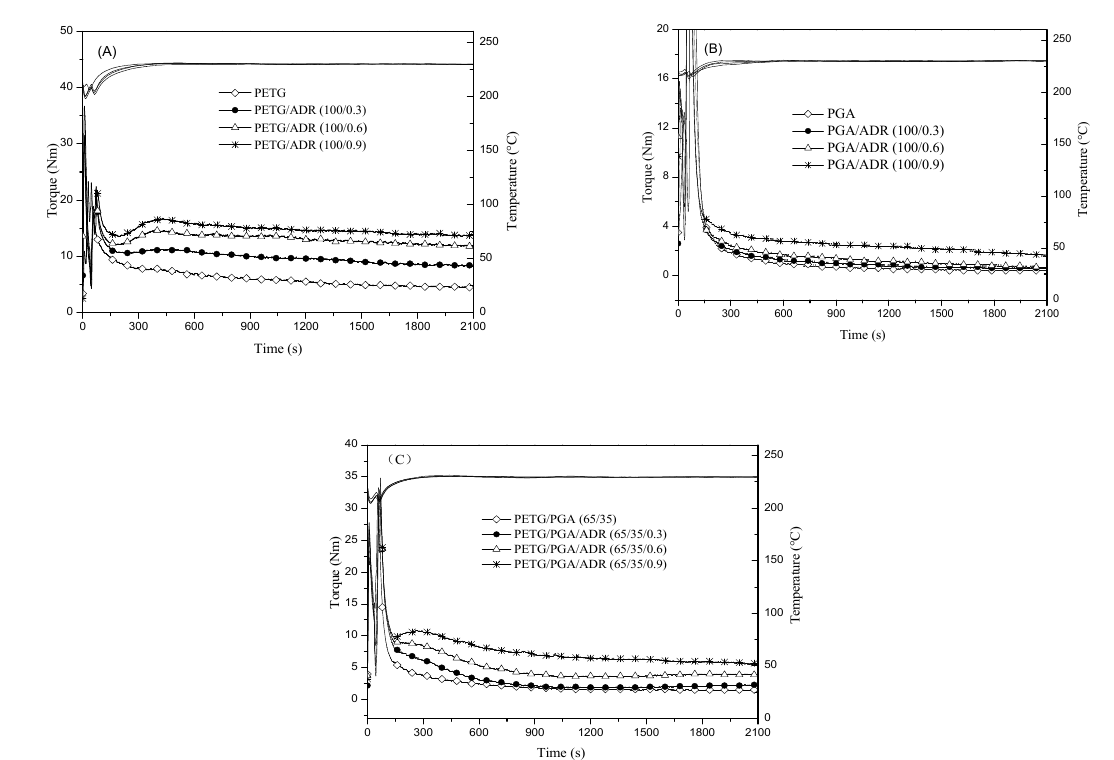
Figure 8. Torque vs. time curves for ( A ) PETG/ADR (100/x), ( B ) PGA/ADR (100/x), and ( C ) PETG/PGA/ADR (65/35/x) (x = 0, 0.3, 0.6, and 0.9).